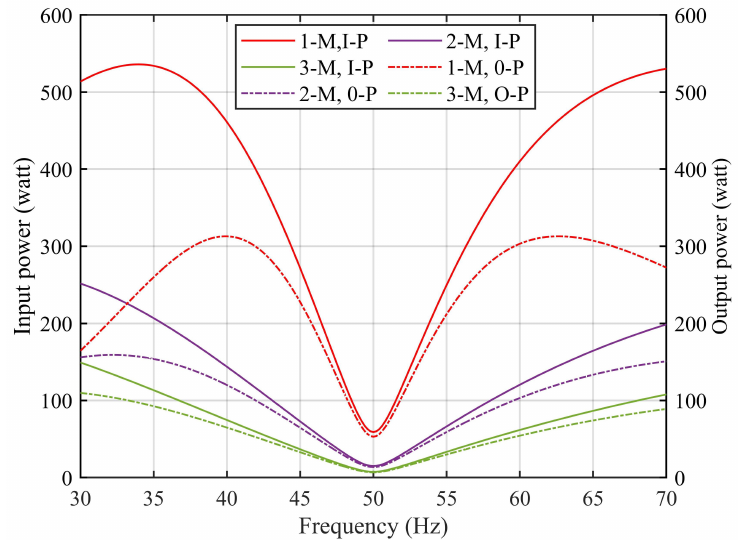
Figure 21. Input and output power of proposed